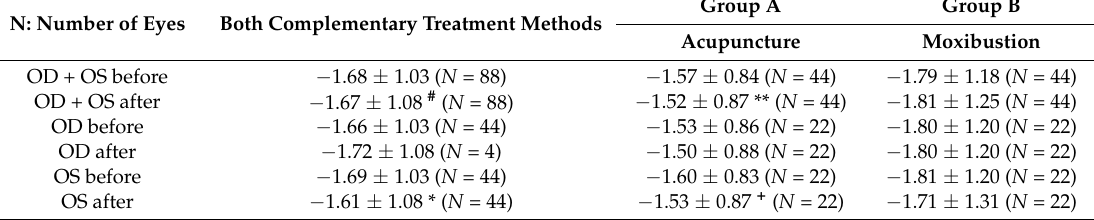
Table 2. Diopters of the right (OD) and left (OS) eye before and after the two treatment methods (N = number of